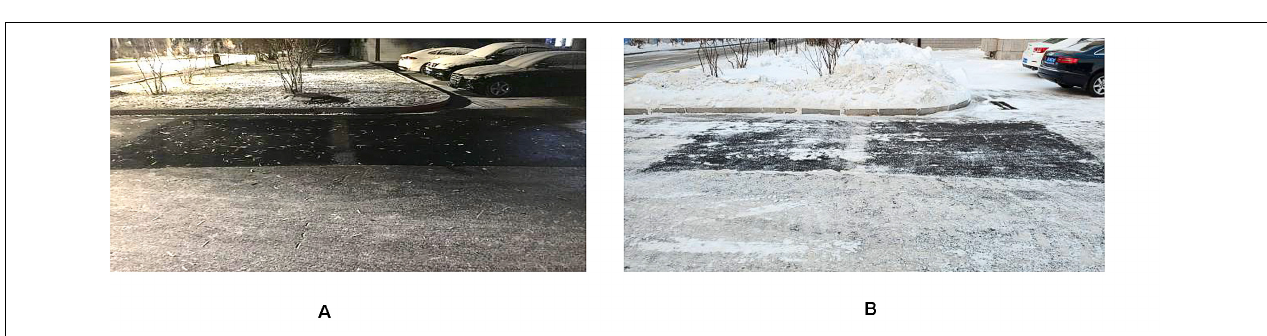
FIGURE 8 | Ice-road adhesion force of different times of freeze-thaw cycle: (A) AEAB-1-coated specimen. (B) AEAB-2-coated specimen. The dash line in the figure indicates the ice-road adhesion of uncoated specimens that do not experience the freeze-thaw cycle.